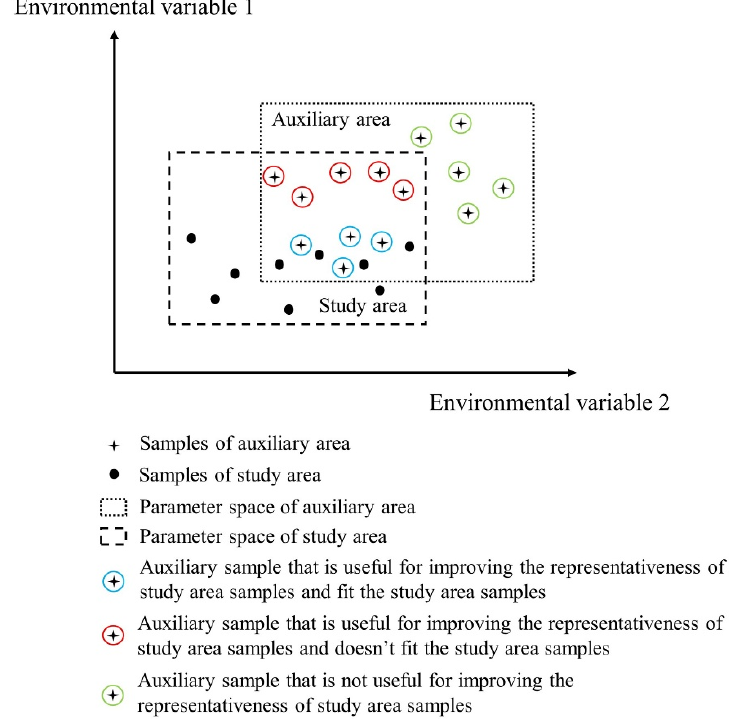
Figure 2. A general overview of the results that can be obtained from the proposed algorithm, highlighting the auxiliary samples with different representativeness contributions and different similarities to study area samples.